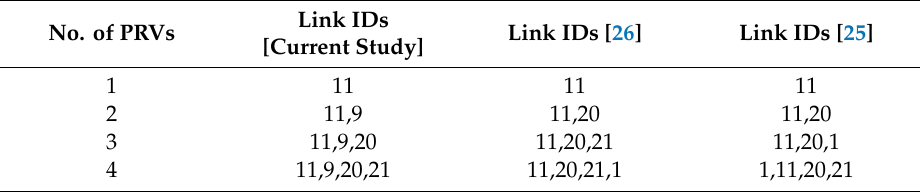
Table 2. Optimal PRV locations for the WDS benchmark with three demand